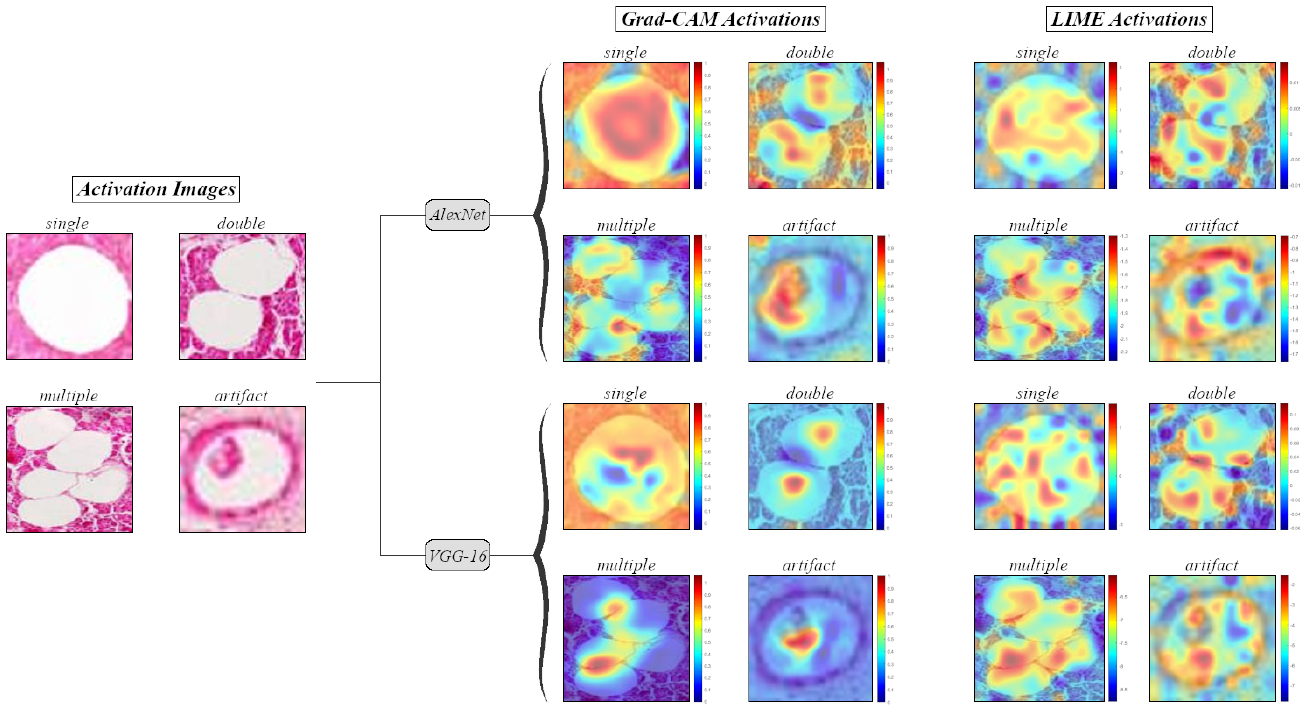
Figure 5. Representation of the most informative features in microscopic tissue anatomies. The Grad-CAM heatmaps reveal (in yellow–red) that the presence of external curves is taken more into account when classifying “single” and “double” fat structures. Small gaps and angular (V-shaped) edges, on the other hand, are the key to identifying “multiple” steatosis regions. The presence of an erythrocyte in the pancreatic vein mainly leads to its classification as a histological “artifact”. The LIME Grad-CAM activations show additional filtered texture features within the histological objects. In both activation methods, it turns out that the deeper VGG-16 architecture performs a more selective or scattered search of informative features, which leads to less mean fat quantification error than the AlexNet model (Table 5) and probably less